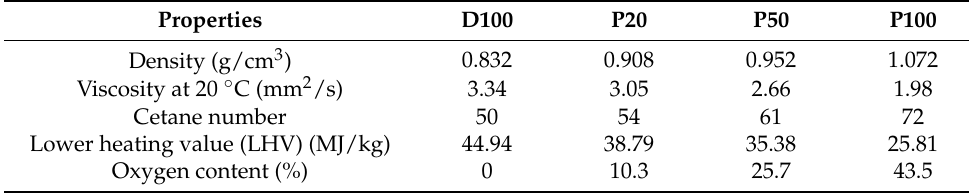
Table 2. Properties of the test